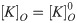
Fast subsystem producing SBs.(A) The phase space of the system of Eqs 3’–5’. Nullclines (solid red lines) and vector-fields (arrows) are calculated for [K]O=[K]O0; dashed nullclines are for [K]O=[K]O0+10mM. Purple curve is a trajectory. (B) the traces of V(t) and xD(t). The parameter values correspond to the basic set of parameters, except the noise amplitude σ/gL = 40 mV.